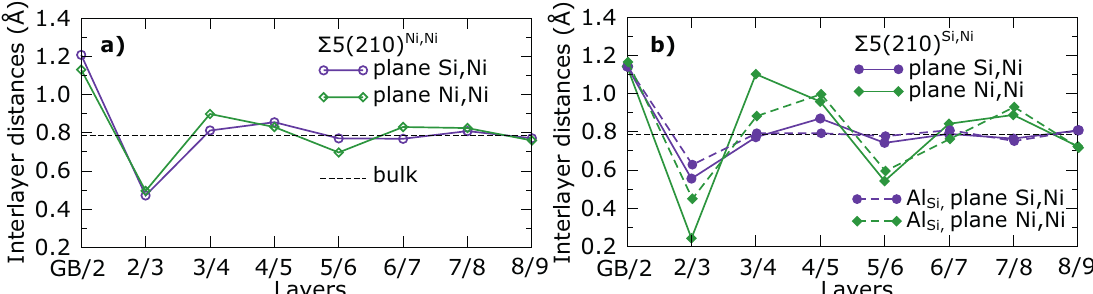
Figure 9. Ab initio computed distances between the (210) atomic planes in the supercells modeling ( a ) Σ 5(210) Ni,Ni and ( b ) Σ 5(210) Si,Ni interface states without (solid line) and with (dashed line) substituted Al atom at GB compared with the value calculated for the